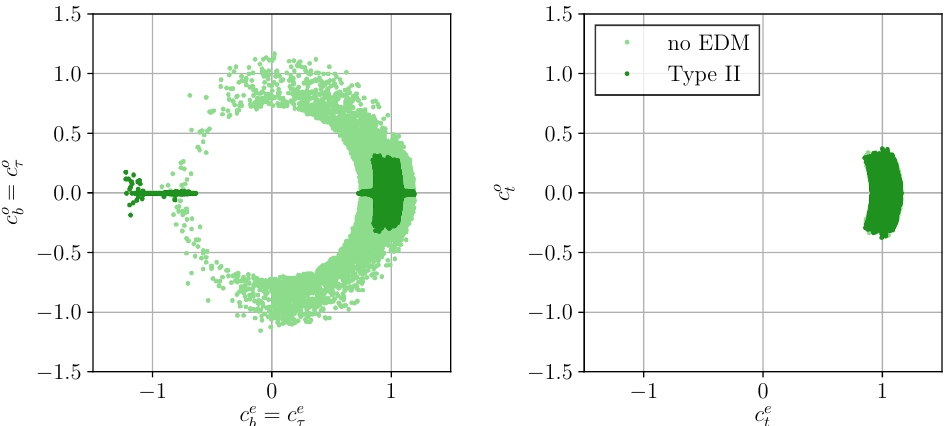
Figure 3 . C2HDM Type II, h and top quarks (right) for sample 1 (dark) and sample 2 (light).